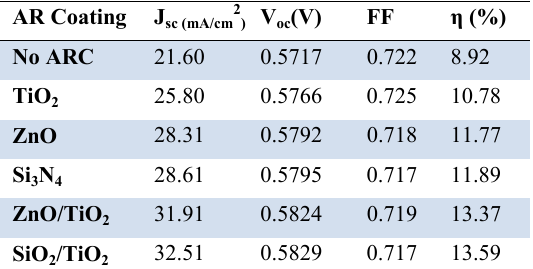
Table 1. Photovoltaic data of Si solar cells with SLARC and DLARC under AM1.5